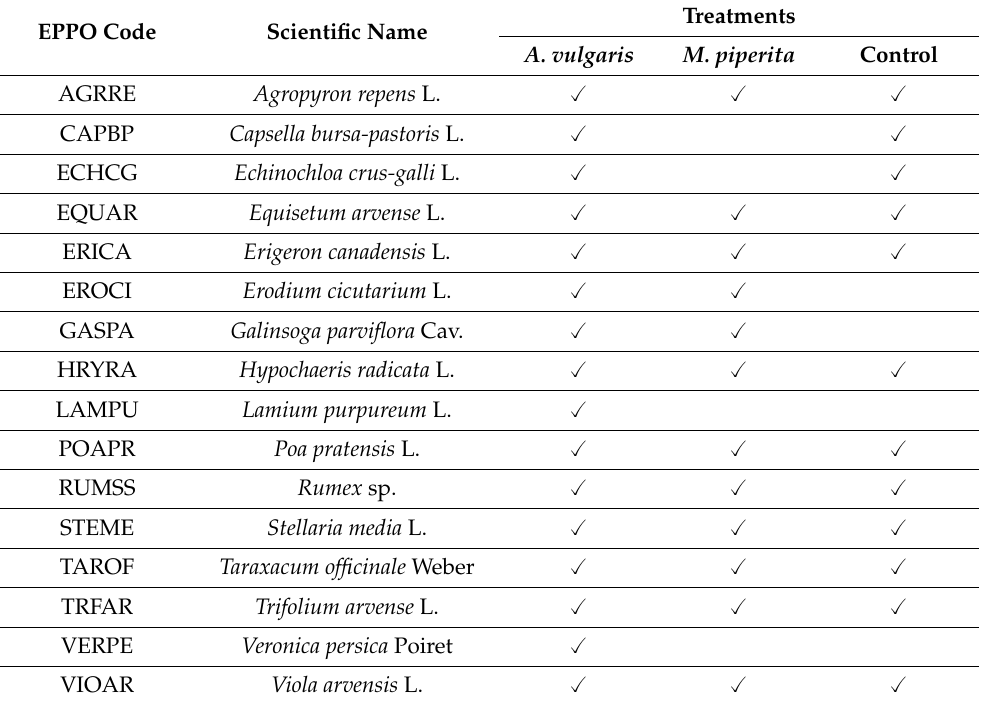
indicates the presence of the species in the respective treatment